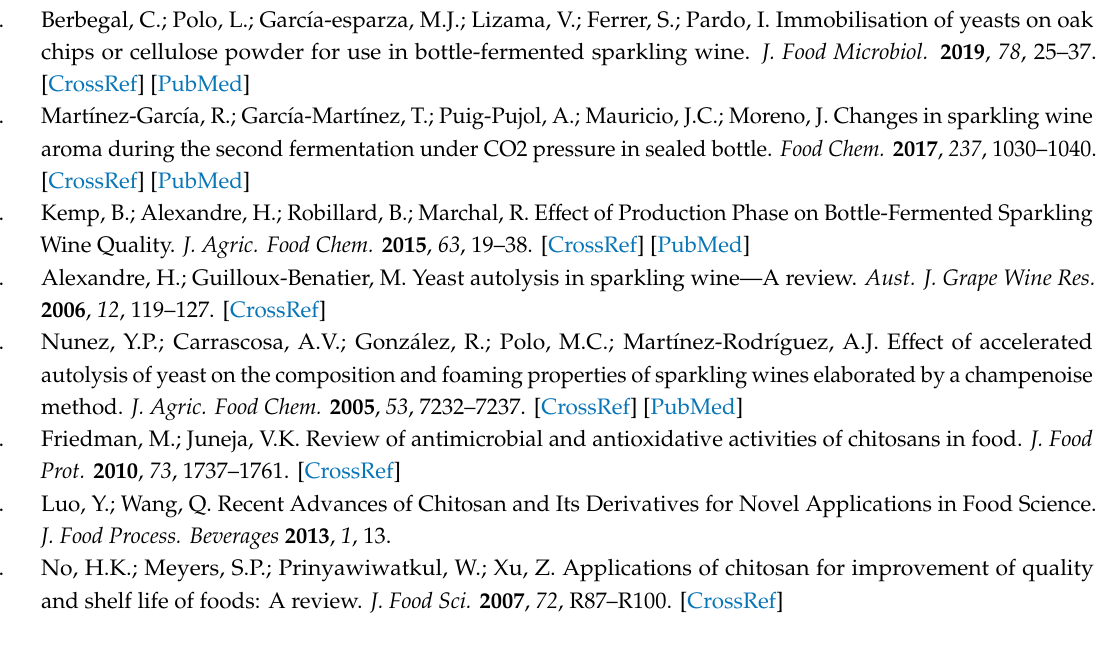
Table S1: Volatile compounds (mg / L) detected after second alcoholic fermentation (2nd AF) and after 12 months of storage “sur lie” in control (CTRL) and chitosan treated (KT) samples. In the same row, di ff erent letters indicate significant di ff erences according to Tukey’s test ( p < 0.05). n =